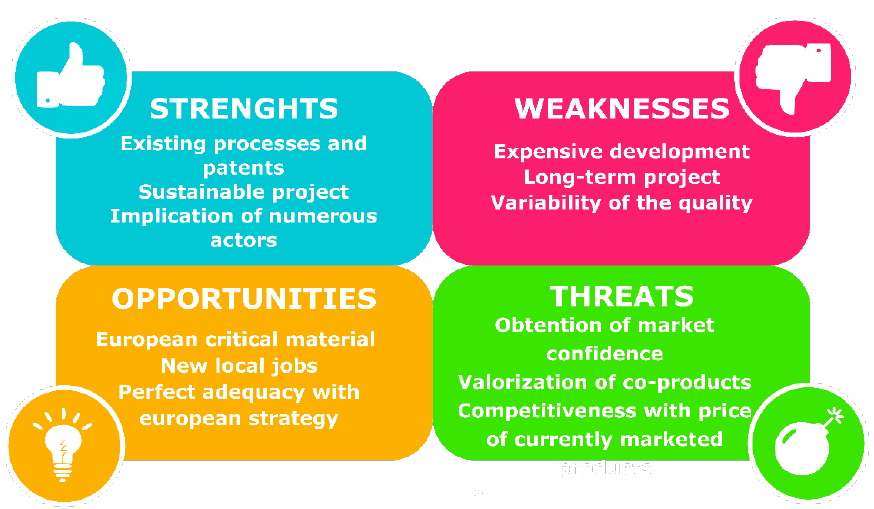
Figure 12. Strengths-Weaknesses-Opportunities–Threats (SWOT) analysis of guayule development.